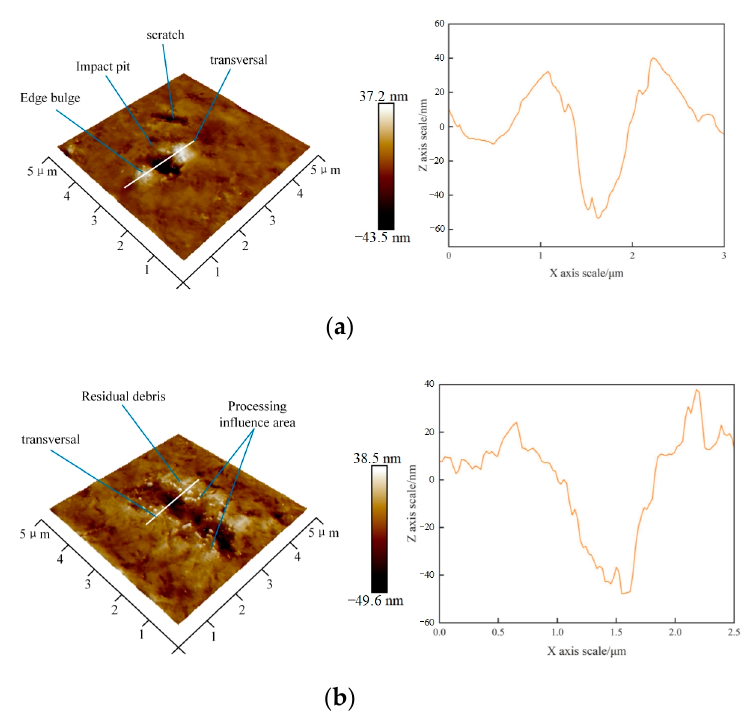
Figure 8. Micromorphology after 0.7 A current machining. ( a ) Small pit and pit section profile. ( b ) Large pit and pit section profile. ( b ) Large pit and pit section